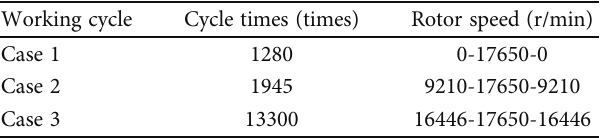
Table 1: 1000 h load spectrum of an aero-engine